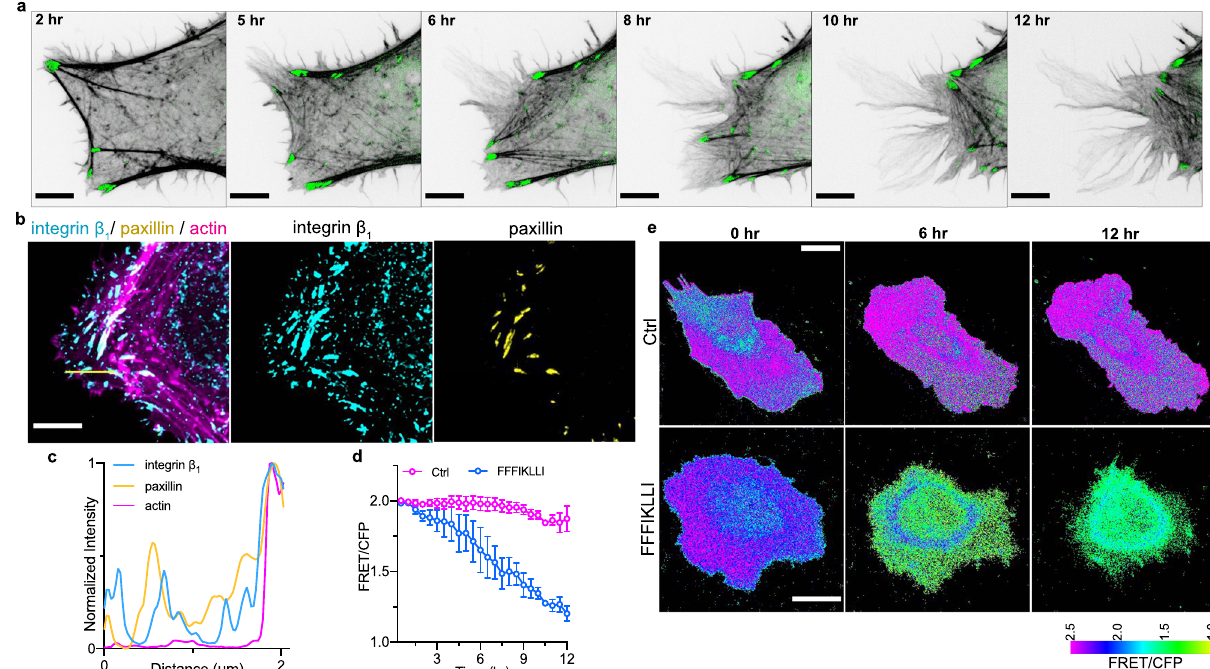
Fig. 4 | Nano fi laments with super high ligand density induced uncoordinated FA dynamics preventing trailing edge retraction. a Time-lapse series showing actin cytoskeleton (grey) and paxillin (green) in HuH-7 cells expressing mRuby- Lifeact-7 and mGFP-paxillin 49 upon the treatment of FFFIKLLI (100 μ M) for 12hr. Scale bars represent 2 μ m. Three independent experiments were performed. b F-actin phalloidin staining (magenta), integrin β 1 (cyan) and paxillin (yellow) immuno fl uorescencein HuH-7 cellafter12htreatmentofFFFIKLLI(100 μ M).Scale bar represents 2 μ m. c Fluorescence intensity distribution pro fi le of integrin β 1, paxillin, and actin cytoskeleton along the yellow line on merged image of b . d 12h